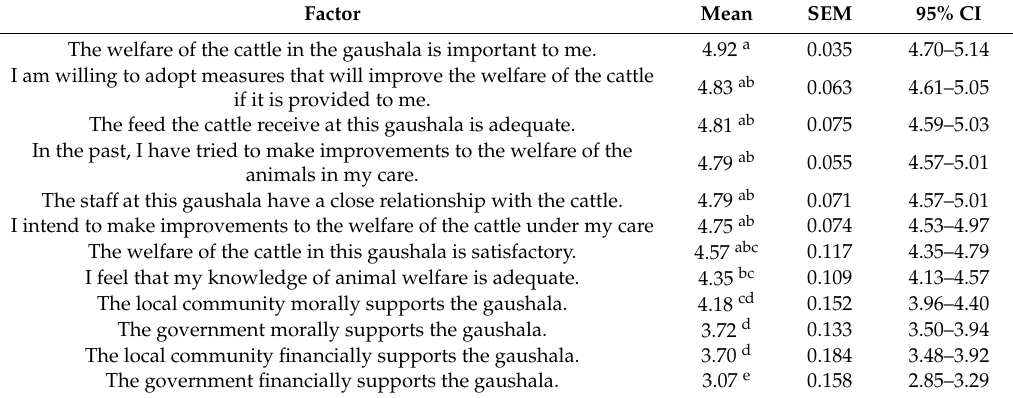
Table A1. Mean responses to various attitudes questions posed to cow shelter managers on a scale of 1 strongly disagree to 5 strongly agree (r 2 =